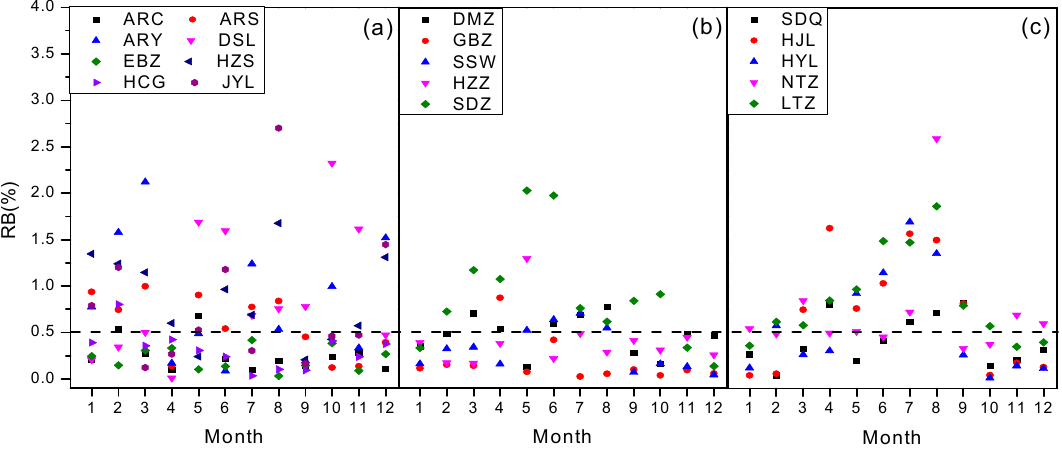
Figure 5. Monthly relative bias (RB) of the observations from the 18 stations within 1-km MODIS LST pixels. ( a ), ( b ) and ( c ) respectively show the monthly RB of the stations in the upstream, midstream and downstream of the Heihe River Basin (HRB).